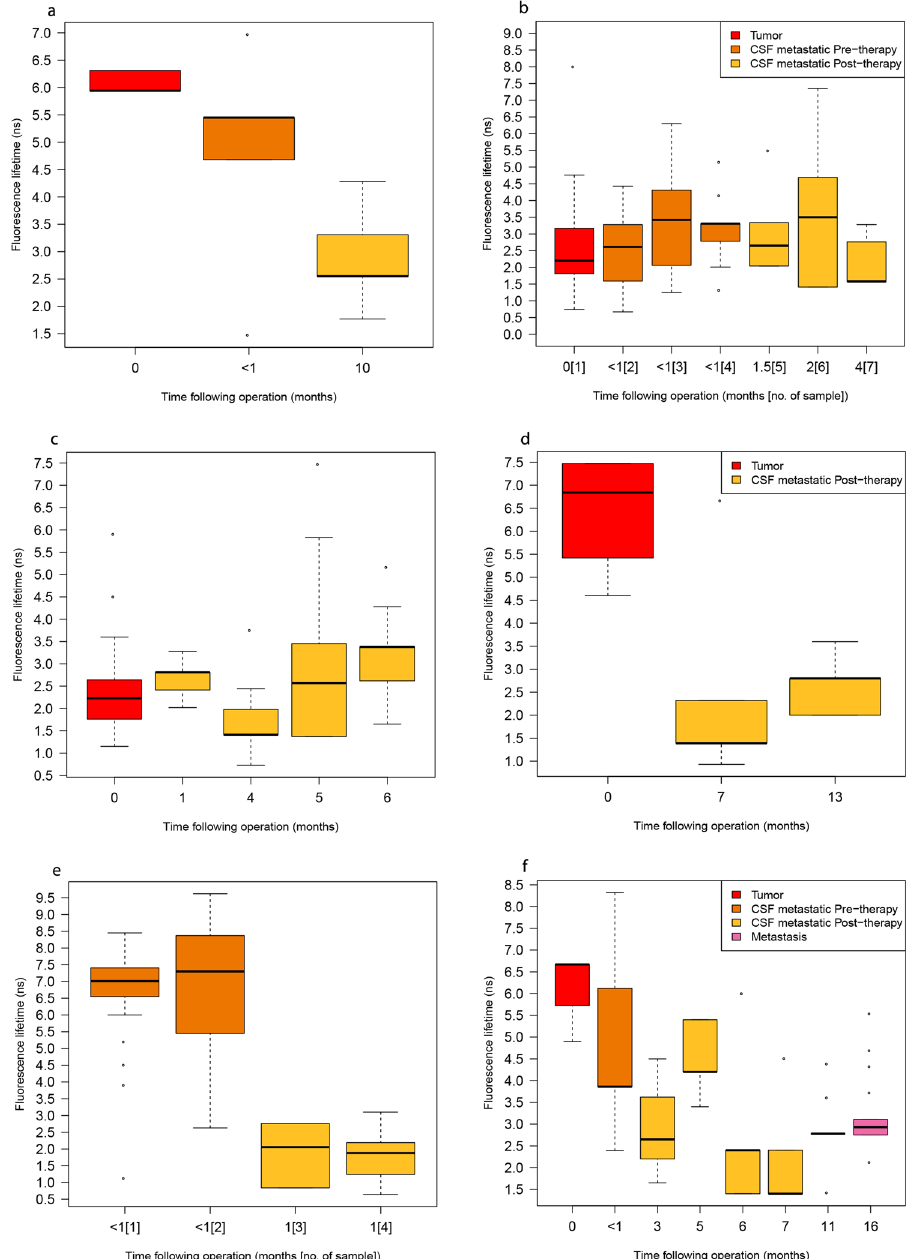
Figure 2. Fluorescence lifetime for each stage of therapy in 5 patients with medulloblastoma, ( a ) patient 3, ( b ) patient 6, ( c ) patient 7, ( d ) patient 8, ( e ) patient 13, and one patient with ATRT ( f ), patient 10. (Patient numbers are keyed to Tables 1 and